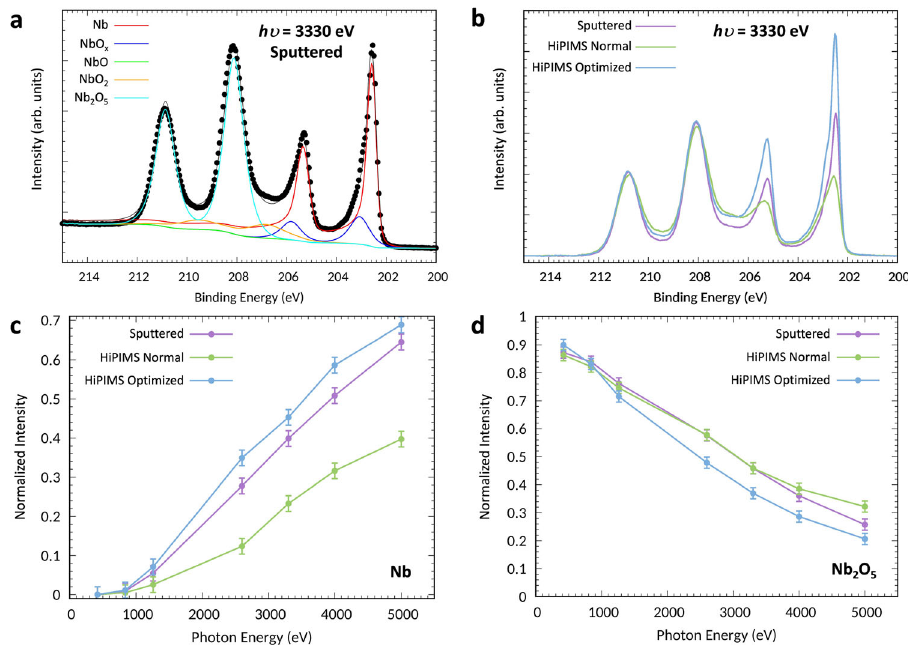
Fig. 2 X-ray photoemission spectroscopy (PES) of the Nb fi lms with varying photon energy. a Representative PES spectrum of the Nb 3 d 3/2 and 3 d 5/2 core levels, measured on the sputtered fi lm for a photon energy ( h ν ) of 3330 eV (black dots) and fi t with fi ve components. b Measured spectra for all three fi lm types at 3330 eV, normalized to the intensity of the Nb fi lm, the measured intensity of the Nb ( c ) and Nb 2 O 5 component. For each 2 O 5 ( d ) peaks are plotted at several photon energies. The sum of the signals from the different oxidation states in a given fi lm is normalized to one, and the error bars show a 1% error, as estimated from the signal-to-noise of measured data. The intensity of Nb and Nb 2 O 5 increase and decrease with energy, respectively, indicating the presence of a surface oxide layer.